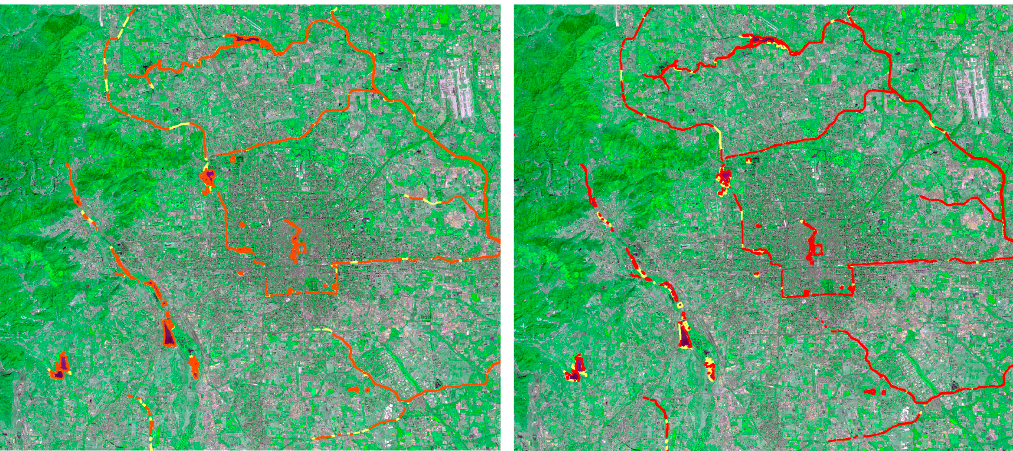
Figure 12. The comparative boundary extraction results utilizing different pan-like sharpening approaches from the Sentinel-2 image (true color synthesis) of Beijing. The red lines denote the results from the FPC ( left ) and MRSB ( right ) approaches, whereas the yellow lines indicate the result from the MNDWII approach.